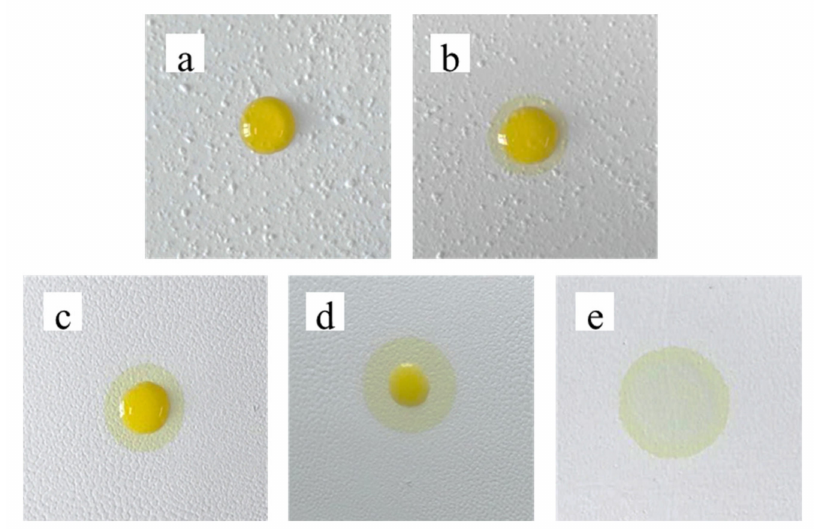
Figure 6. The di ff usion of serum by TiO 2 bifunctional sheets: ( a ) 30 min; ( b ) 2 h; ( c ) 3 h; ( d ) 4 h; ( e ) 5 h. At short stirring times, TiO 2 microspheres agglomerated which led to a lower amount of CA in the bulges, but a higher one in the flat areas and on the surface of the bulges. With a CA to TiO 2 mass ratio higher than 0.50:1, di ff usion was lower as described in 3.2. As time goes on, the water in the serum evaporated and a serum sheet gradually formed on the surface of the TiO 2 bifunctional